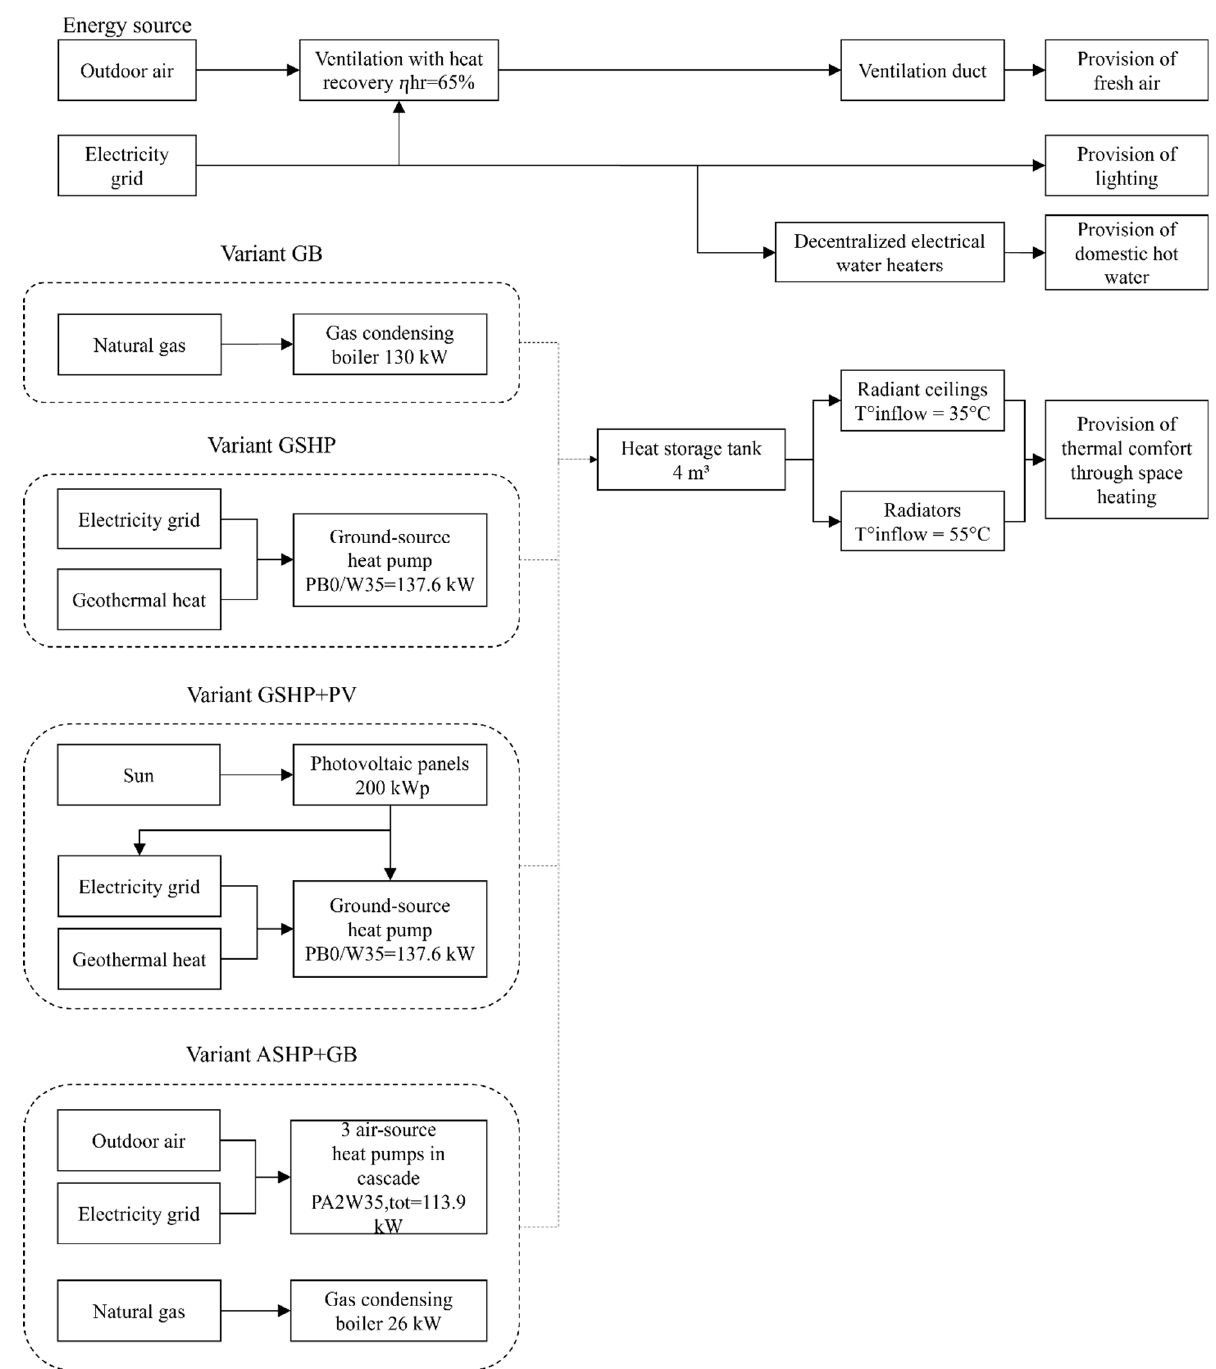
Figure 3. Energy concept and heating system variants.